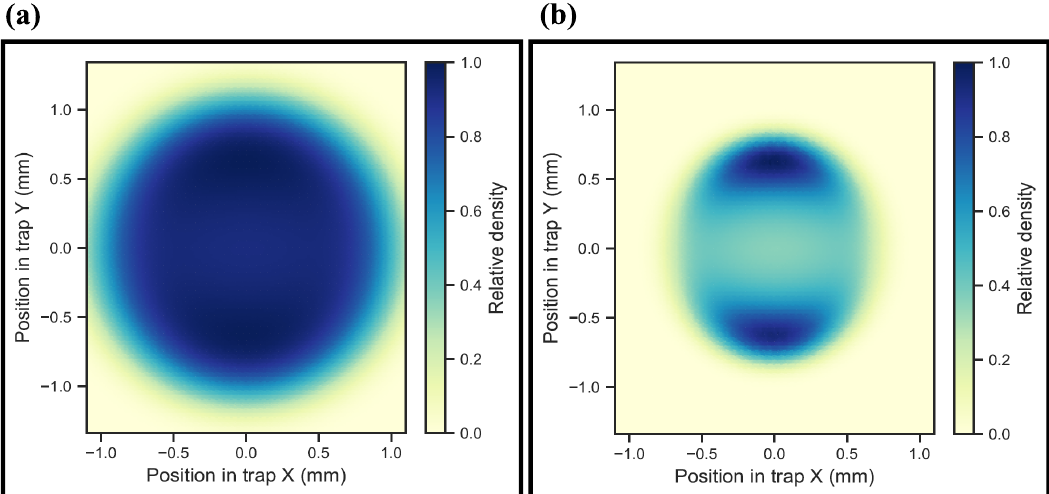
Figure 8. Heatmap representation for the density distribution of ions in the trap. ( a ) Homogenoues ion density distribution at 373 K. ( b ) Ion density distribution at 30 K exhibiting regions of global